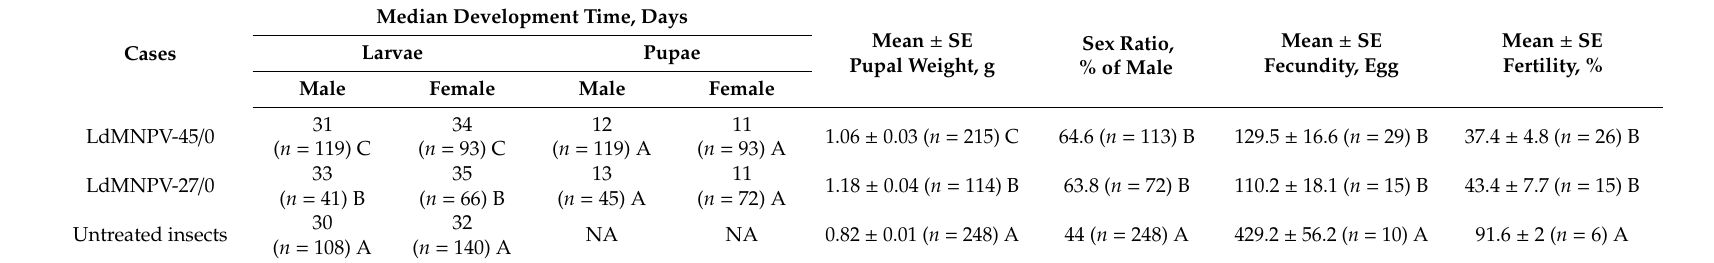
Table 1. Summary of e ff ects of Nucleopolyhedrovirus (NPV) treatment on survivors of Lymantria